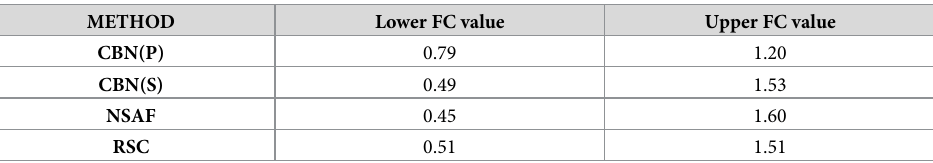
Table 1. Methods fold changes